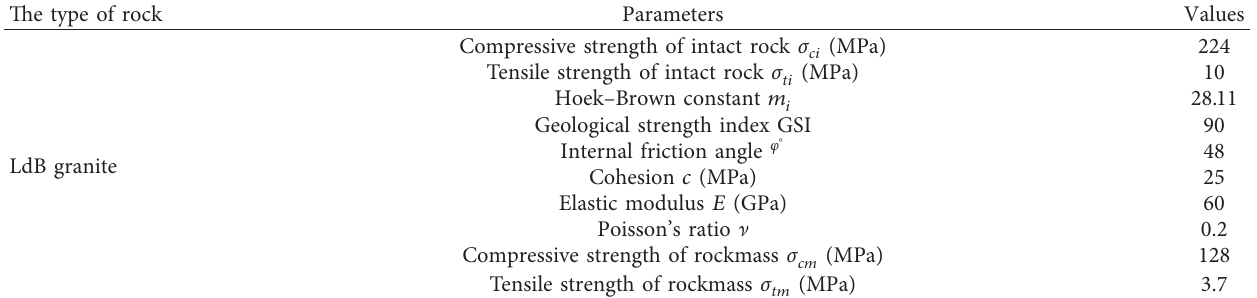
Table 1: Relevant physical and mechanical parameters of Lac du Bonnet granite